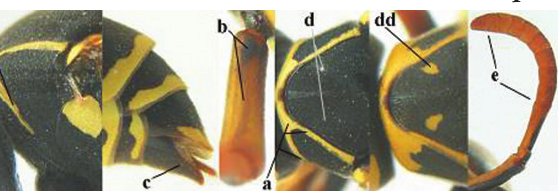
– 11 Transverse yellow band of pronotum narrower medio-laterally than dorso-later- ally near junction with oblique yellow stripes of pronotum (a), rarely narrowed dorso-laterally and slightly widened below it and then mesoscutum usually without yellow markings (d); scapus more or less dark brown or blackish baso- ventrally (b), apical half of hypopygium often entirely black or dark brown (c), sometimes with small yellow spot, rarely apical quarter of hypopygium yellow; mesoscutum usually without paired yellow spots (d) but sometimes minute, or medium-sized (dd); apical half of antenna more or less darkened dorsally (e); Europe and Palaearctic Asia ..................................... P. nimpha (Christ, 1791)